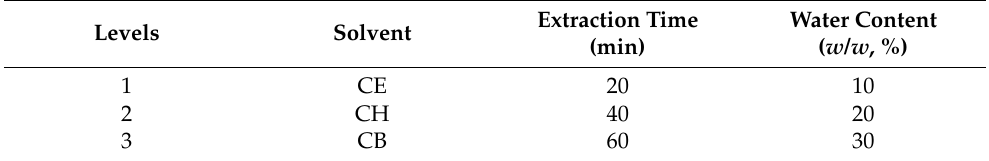
Table 1. Factor design of ultrasonic-assisted deep eutectic solvent extraction. CE: Choline chloride and ethylene glycol, 1:2 molar ratio; CH: Choline chloride and 1,6 hexanediol, 1:2 molar ratio; CB: Choline chloride and 1,4-butanediol, 1:4 molar